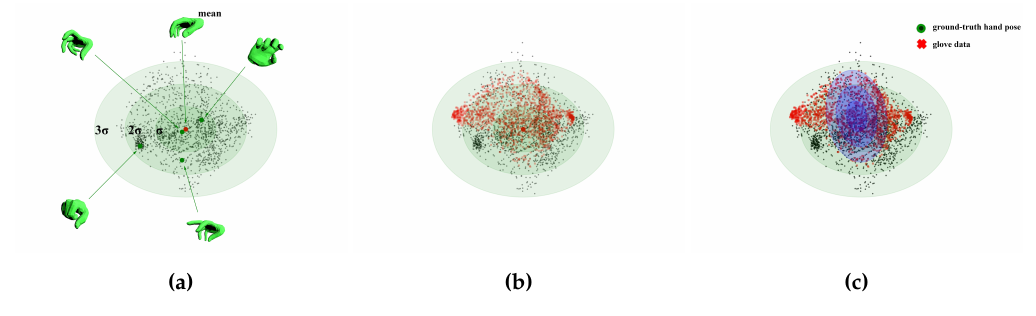
Figure 11. An illustration of the Gaussian distribution in the two-dimensional subspace of PCA. ( a ) The result ˜ θ of ground-truth hand pose(except the six global components) θ on the database of [44]. ( b ) The projection ˜ θ glove of the glove data θ glove into the same subspace in red dots. ( c ) The multivariate ) for the difference between the glove data ˜ θ Gaussian model in blue color N ( µ dif f , Σ (cid:48) glove and dif f corresponding ground truth ˜ θ in the two-dimensional subspace.